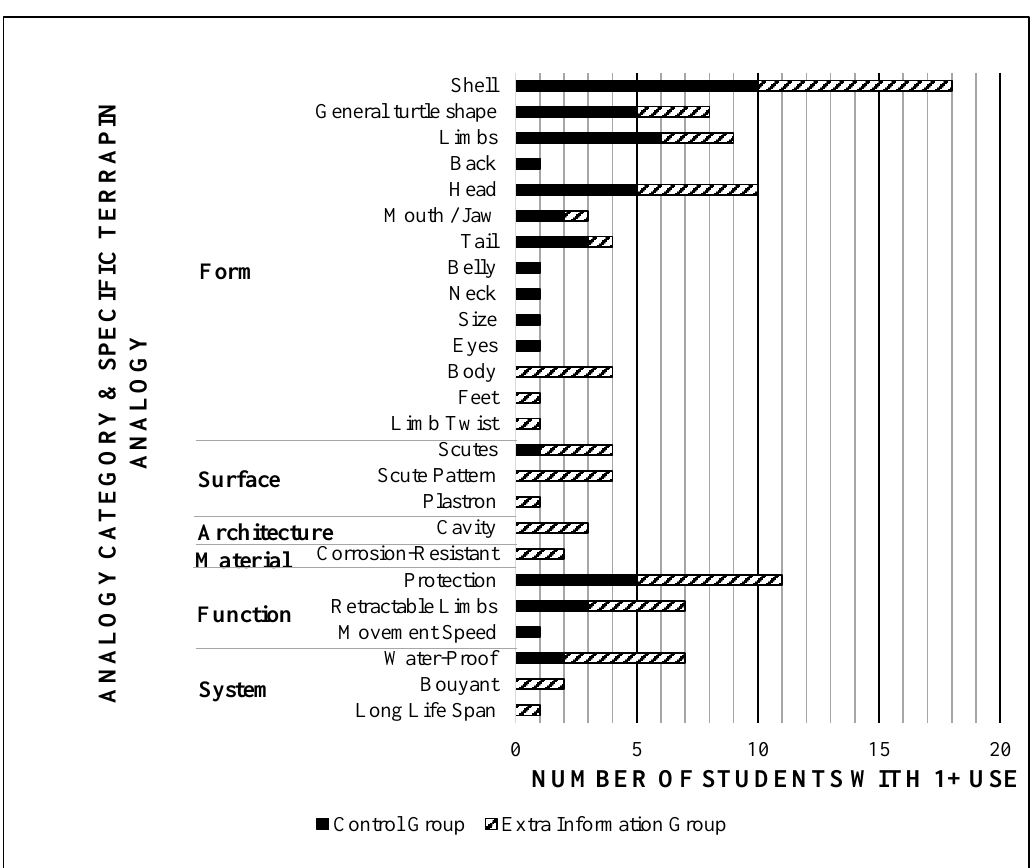
Figure 3. Analogy usage across all study participants. Specific terrapin analogies are grouped based on analogy categories found in Table 1.